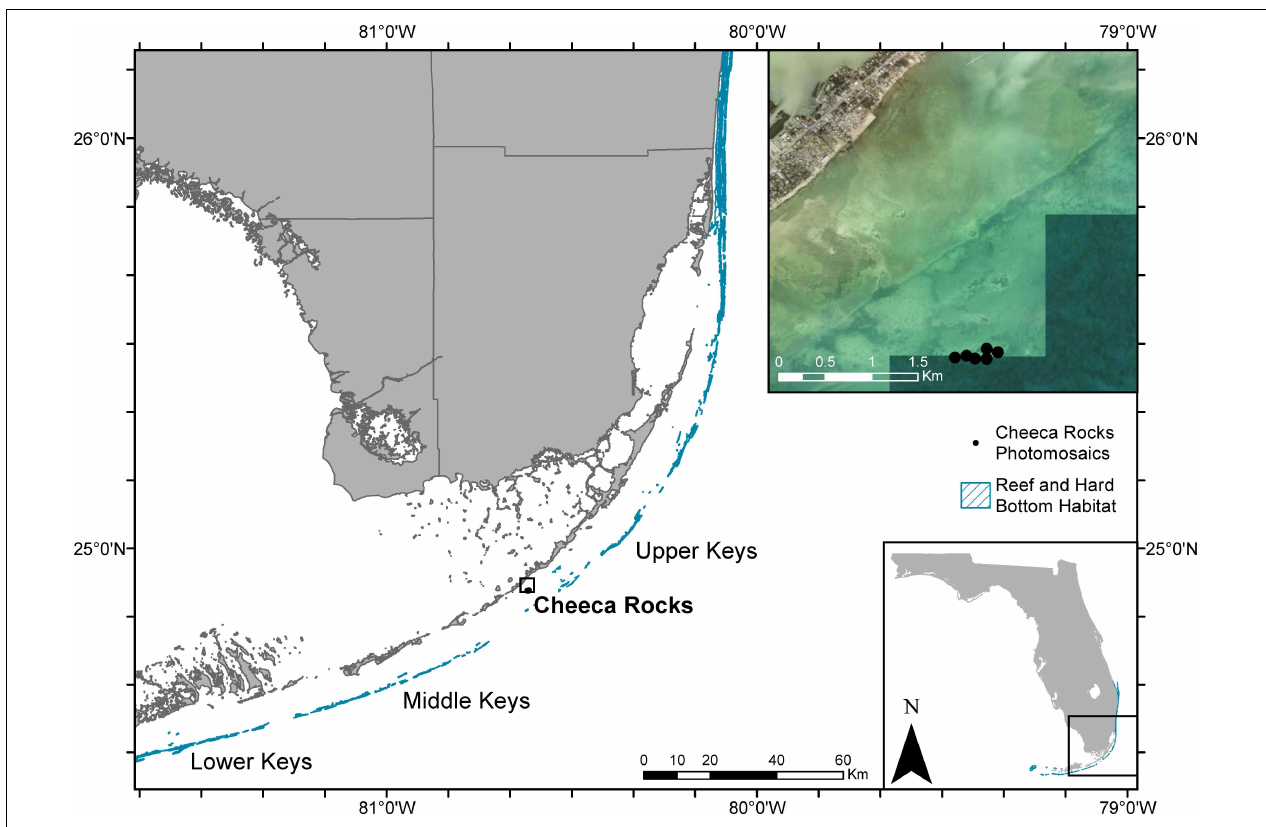
FIGURE 1 | Map of the southern extent of Florida’s coral reef tract including the long-term monitoring plots at Cheeca Rocks. Reef and hard bottom habitat shapefile was sourced from the Florida Fish and Wildlife Conservation Commission-Fish and Wildlife Research Institute, and satellite imagery was sourced from ESRI.